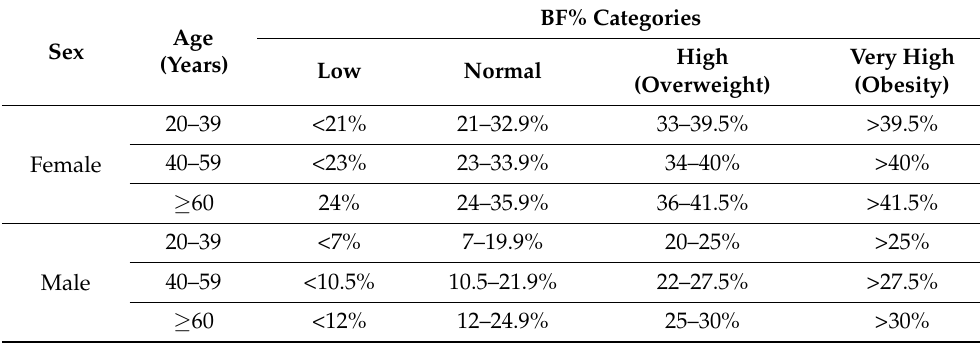
Table 1. Age- and sex-adjusted cutoff values for BF% categories. Age Sex